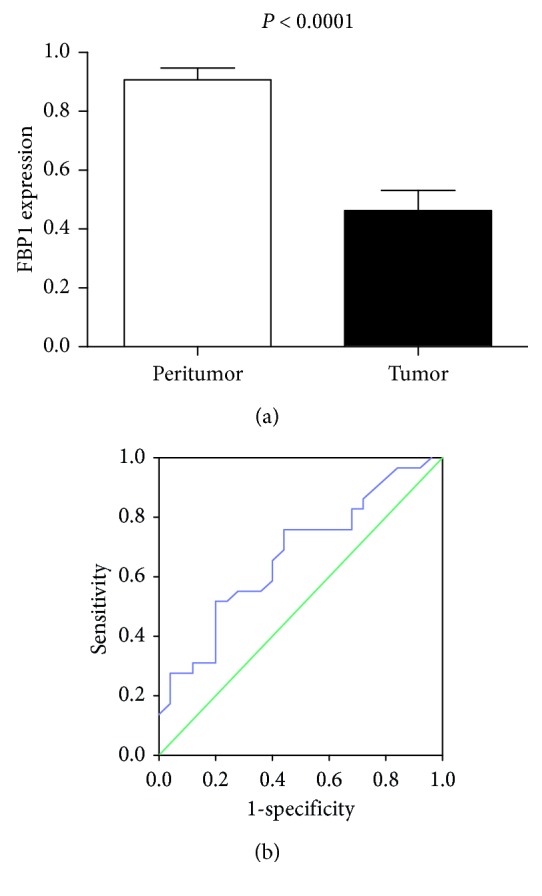
The relationship between 18F-FDG uptake and FBP1 expression in ccRCC. (a) FBP1 expression in ccRCC. The expression of FBP1 in ccRCC tissues (0.46 ± 0.07) was significantly lower than that in corresponding peritumor tissues (0.91 ± 0.04) (P < 0.0001). (b) Receiver-operating characteristic curve analysis of SUVmax in primary tumor to predict FBP1 expression in ccRCC. With an SUVmax of 3.35 as the optimal value, sensitivity and specificity for prediction FBP1 expression were 88.9% and 58.3%, respectively. The area under the receiver-operating characteristic curve was 0.67 (95% confidence interval: 0.53–0.81; P=0.032).